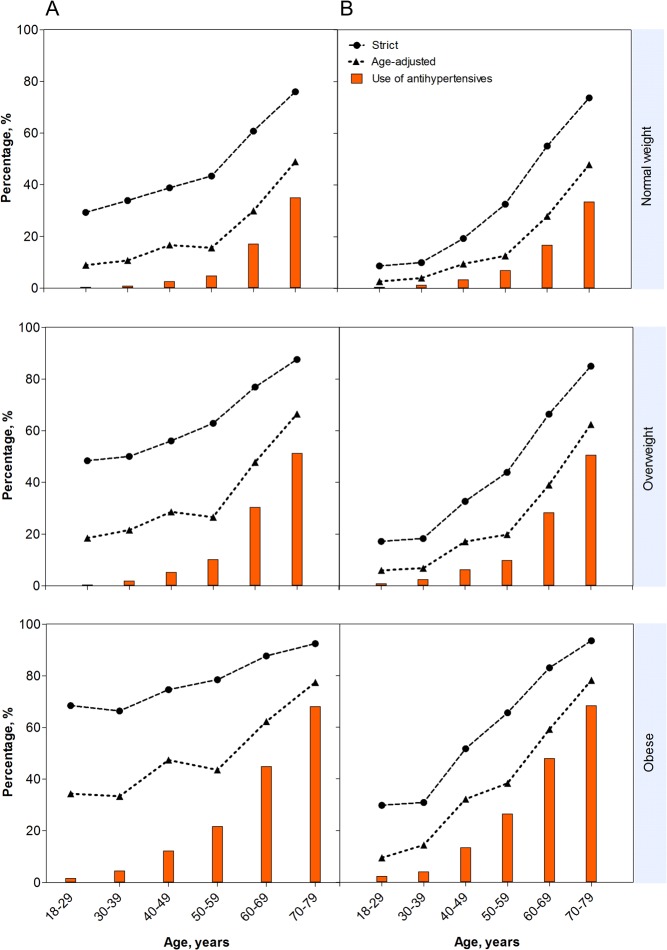
Prevalence of elevated blood pressure, according to the strict and age-adjusted thresholds, including antihypertensive drug use. Left panel A: men, and right panel B: women. BP, blood pressure. Strict blood pressure values are ≥130 mmHg (systolic) or ≥85 mmHg (diastolic) (including those using antihypertensive drugs). Age-adjusted blood pressure values are ≥140 mmHg (systolic) or ≥90 mmHg (diastolic) for those aged <60 years, and ≥150 mmHg (systolic) or ≥90 mmHg (diastolic) for those aged ≥60 years (including those using antihypertensive drugs).